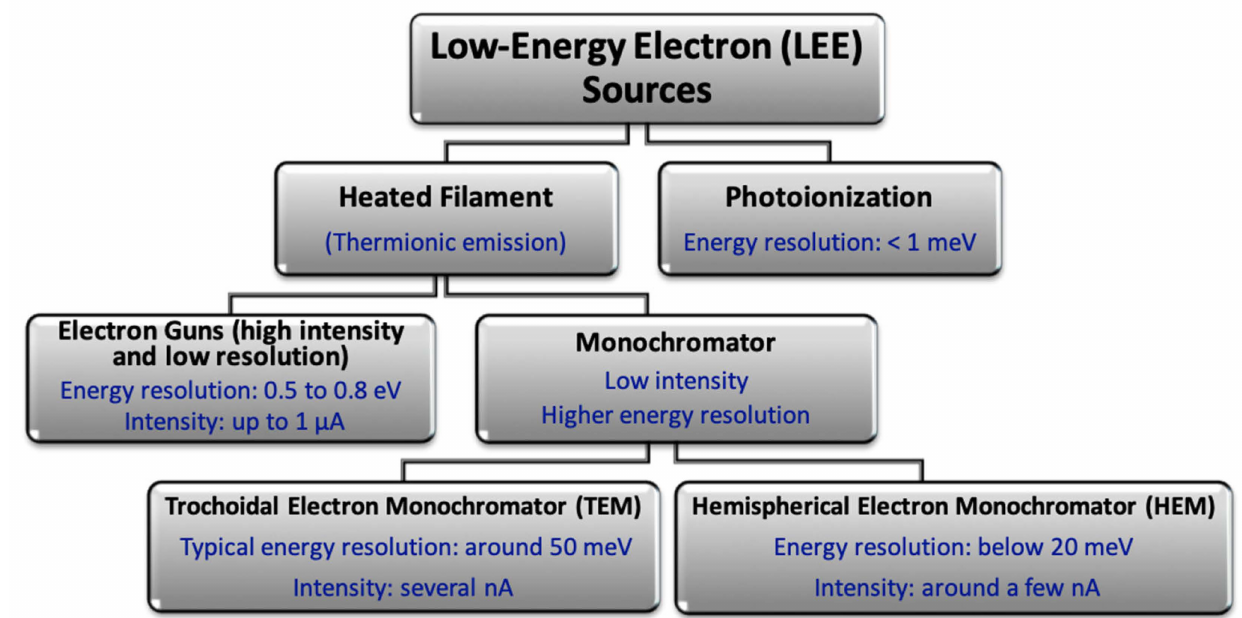
Figure 1. Chart of the different types of electron sources used in LEE experiments under